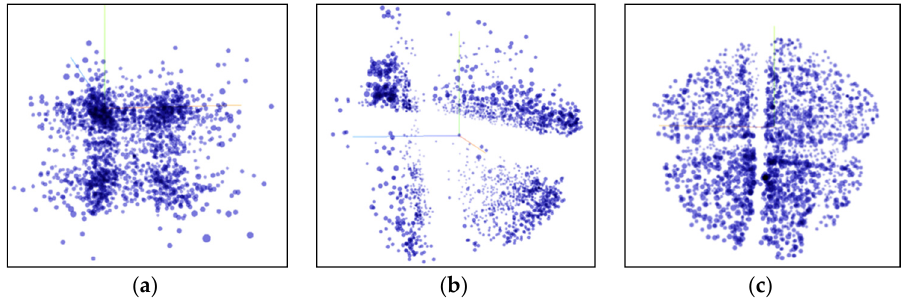
Figure 11. Use the T-SNE algorithm to reduce the dimensional effect. ( a ) Iteration 100 times; ( b ) Iteration 300 times; ( c ) Iteration 1000 times.